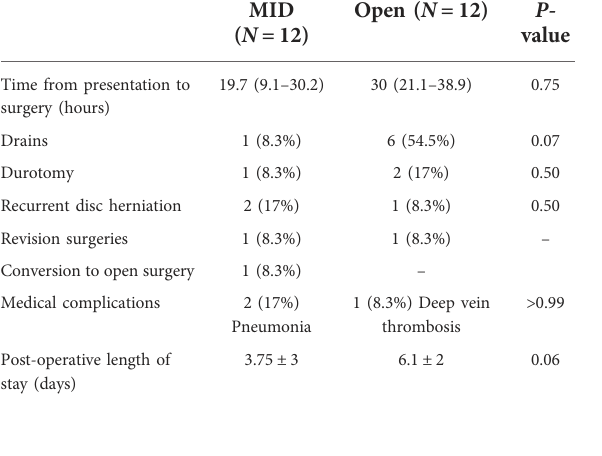
TABLE 3 Surgical data and complications.